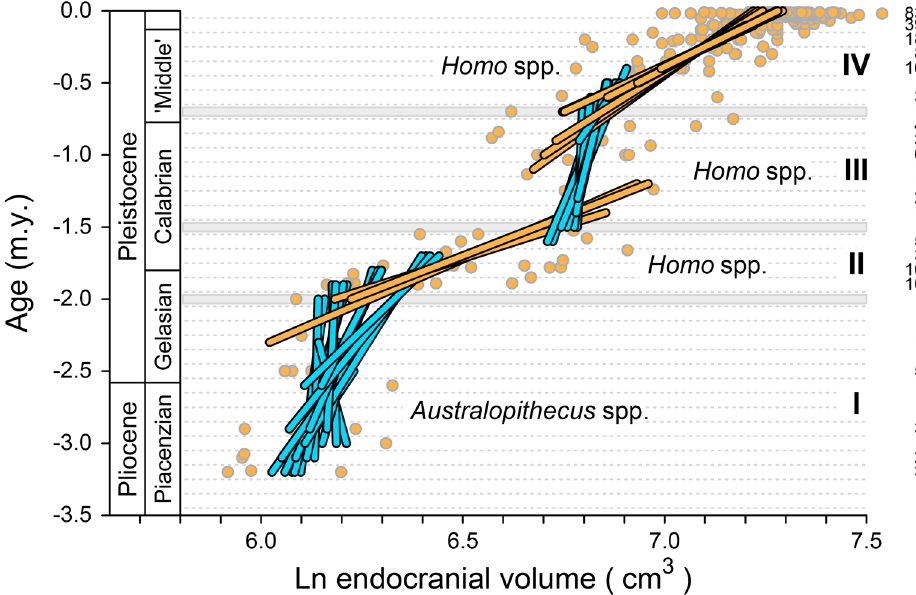
Figure 5. Graphical representation of the time series segments of Fig. 4 that are significantly different from random, plotted on the ln ECV and age axes of Fig. 3. Note that the Phase I–II, Phase II–III and Phase III-IV boundaries are inflections between stationary and directional time series segments, but the phase changes are diffuse in the sense that there is temporal overlap of stationary and directional segments in each transition.